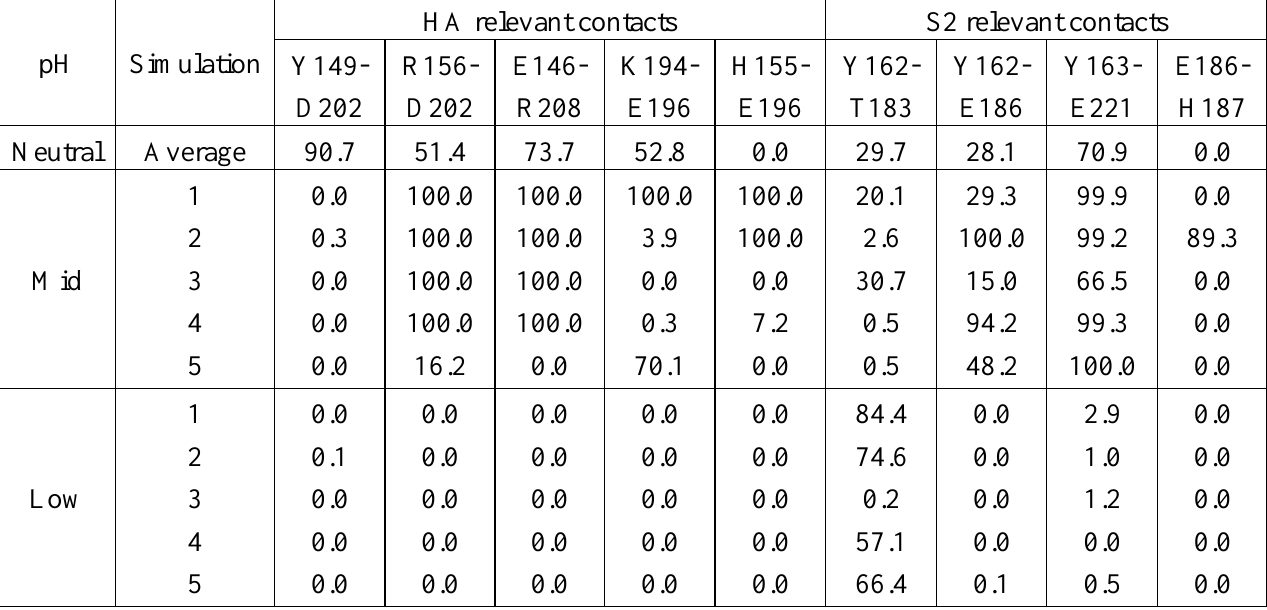
Table 1. Population (in percent of time) for the last 25 ns of polar contacts between pairs of residues in mid- and low pH simulations and the average values for neural pH simulations. All polar contacts listed are between residue side chains, except for |Y162-T183, where the side chain of T183 formed a hydrogen bond with the backbone amide of